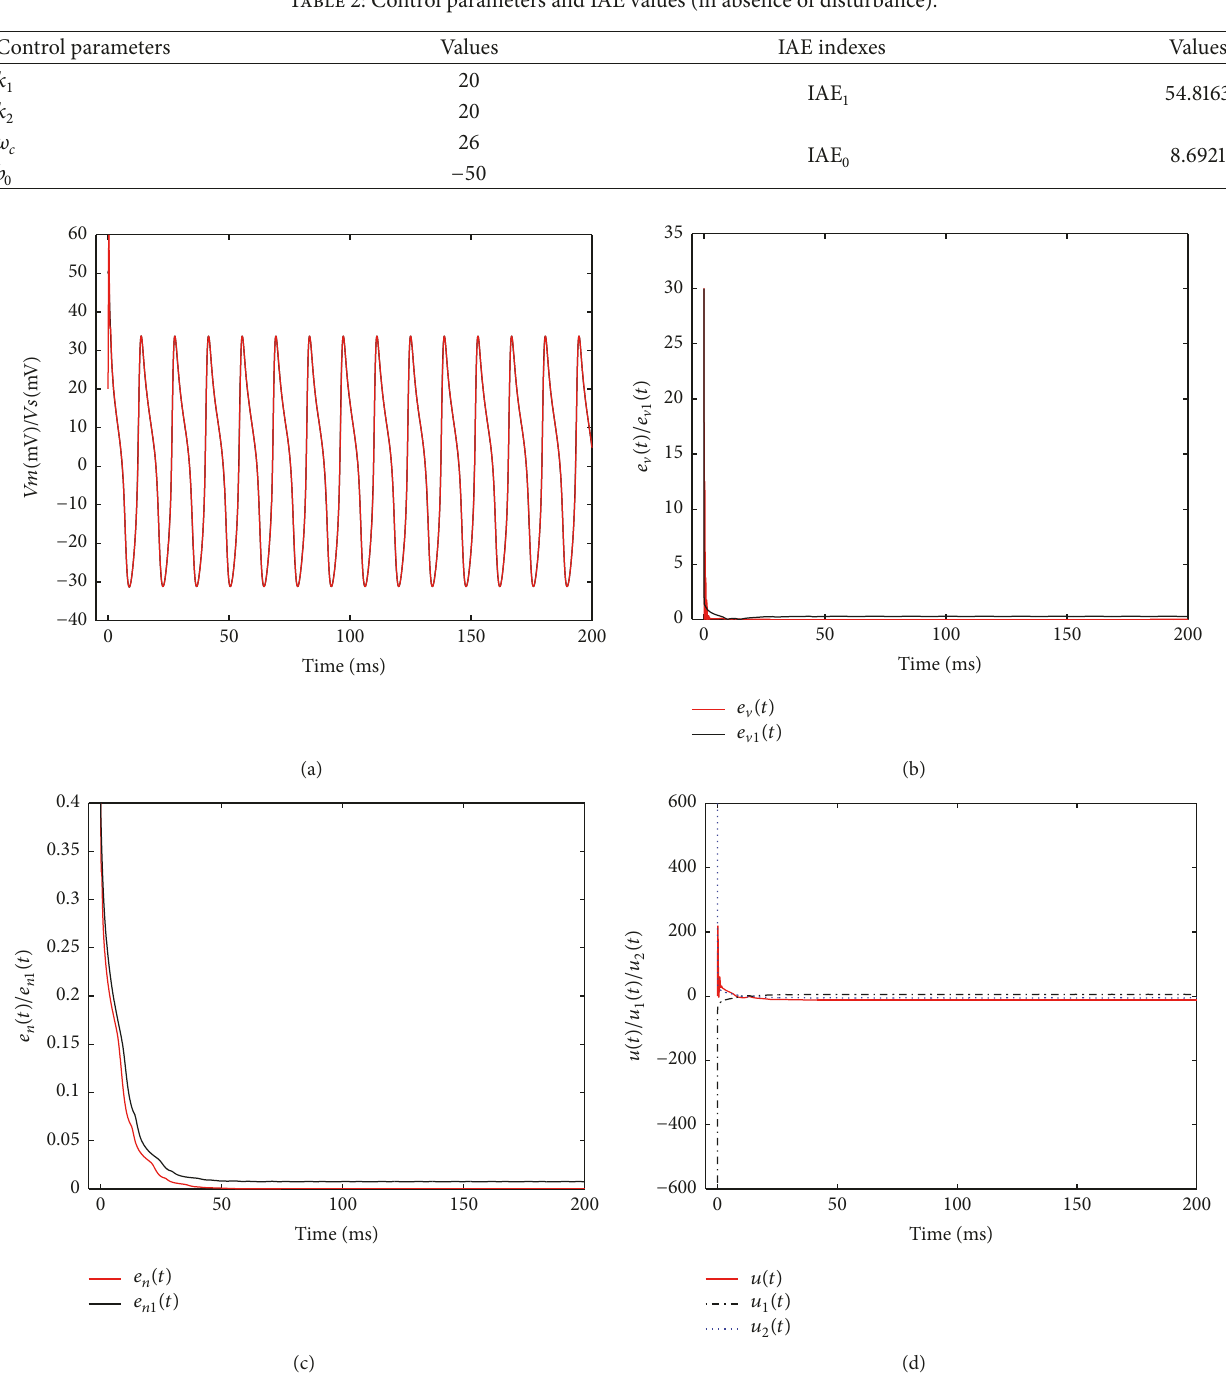
Figure 3: Synchronous performance of Morris-Lecar neurons and the comparison of control inputs (in absence of disturbance).